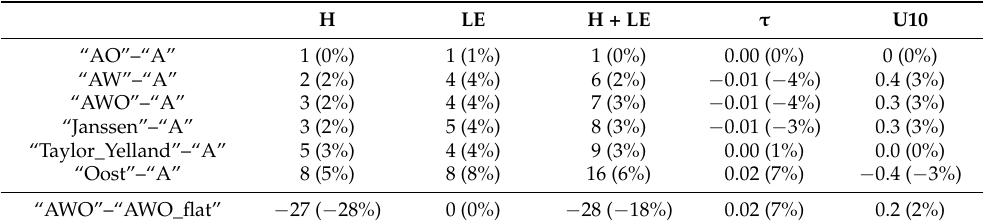
Table 4. Average differences in sensible (H), latent (LE) and total (H+LE) heat fluxes (W m − 2